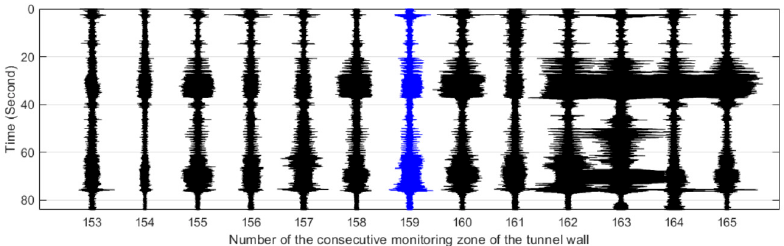
Figure 14. Distributed vibration responses of 13 consecutive monitoring zones under the perturbation of position P4.